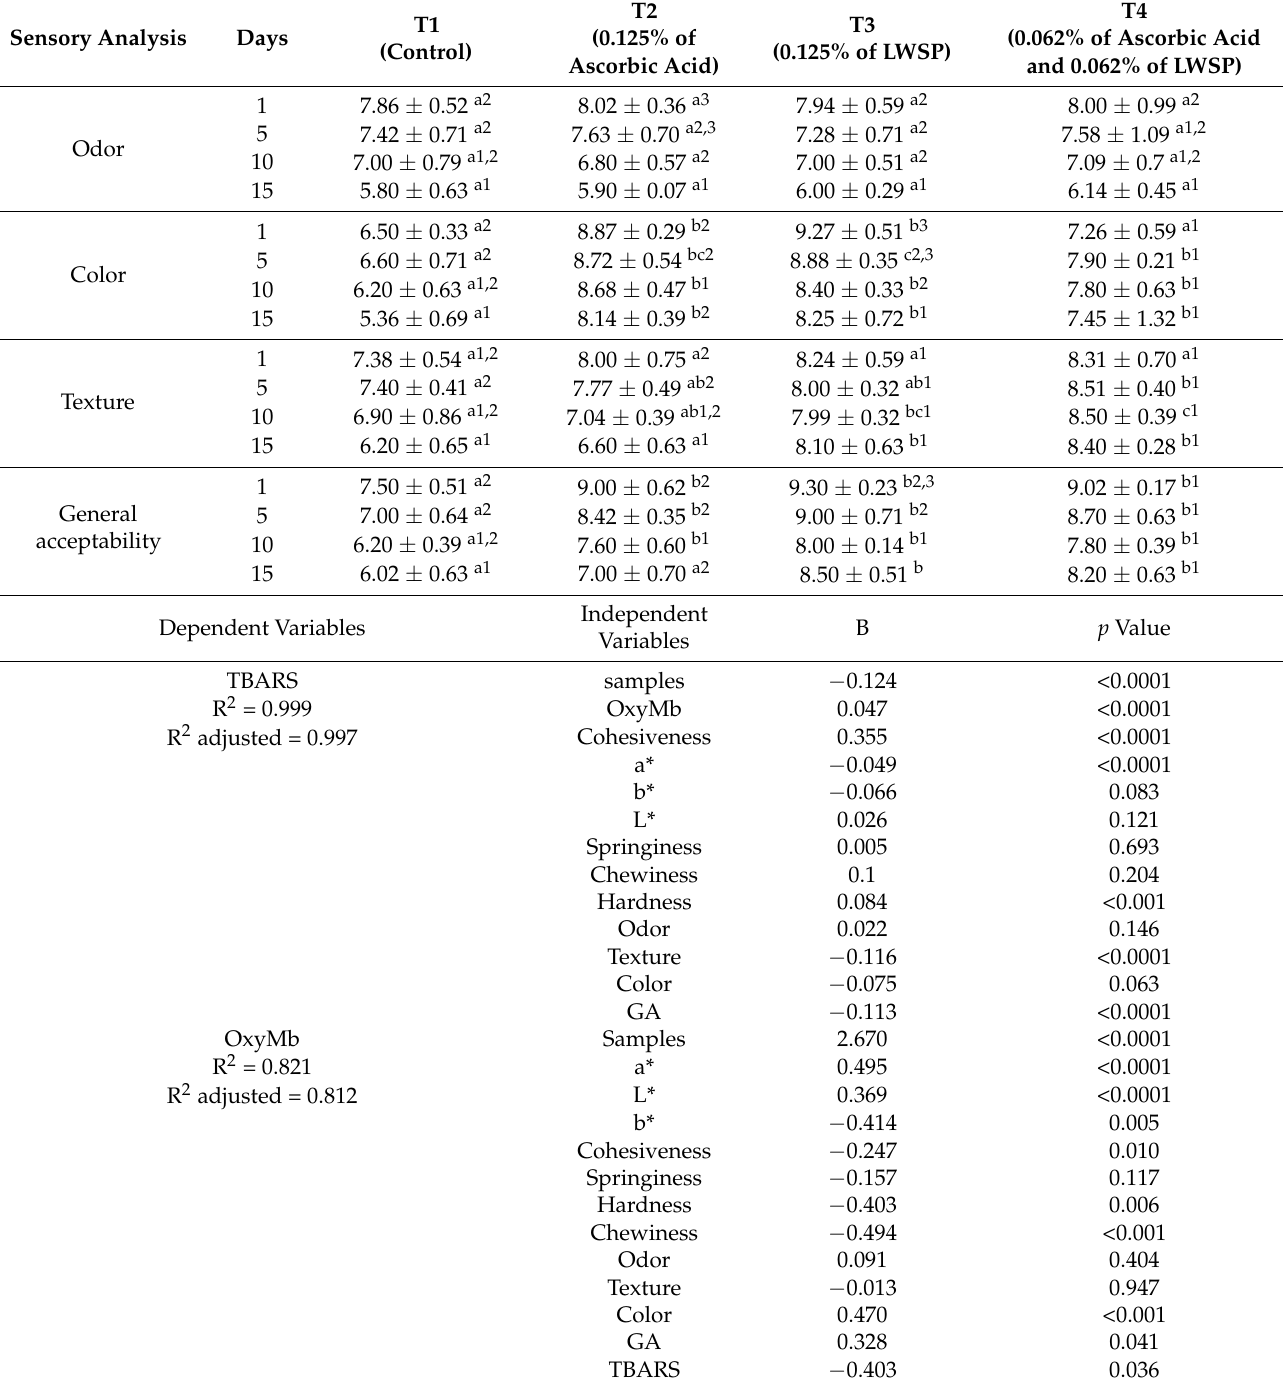
Table 3. A. Sensory analysis of sausage during refrigerated storage. B. Stepwise multiple linear regression analysis between lipid and protein oxidation and color and texture parameters at 15 days of